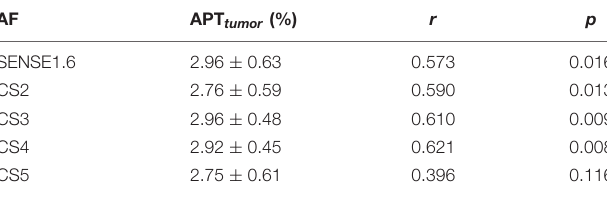
TABLE 8 | Correlation between APT tumor and Ki67. AF APT tumor (%) r p SENSE1.6